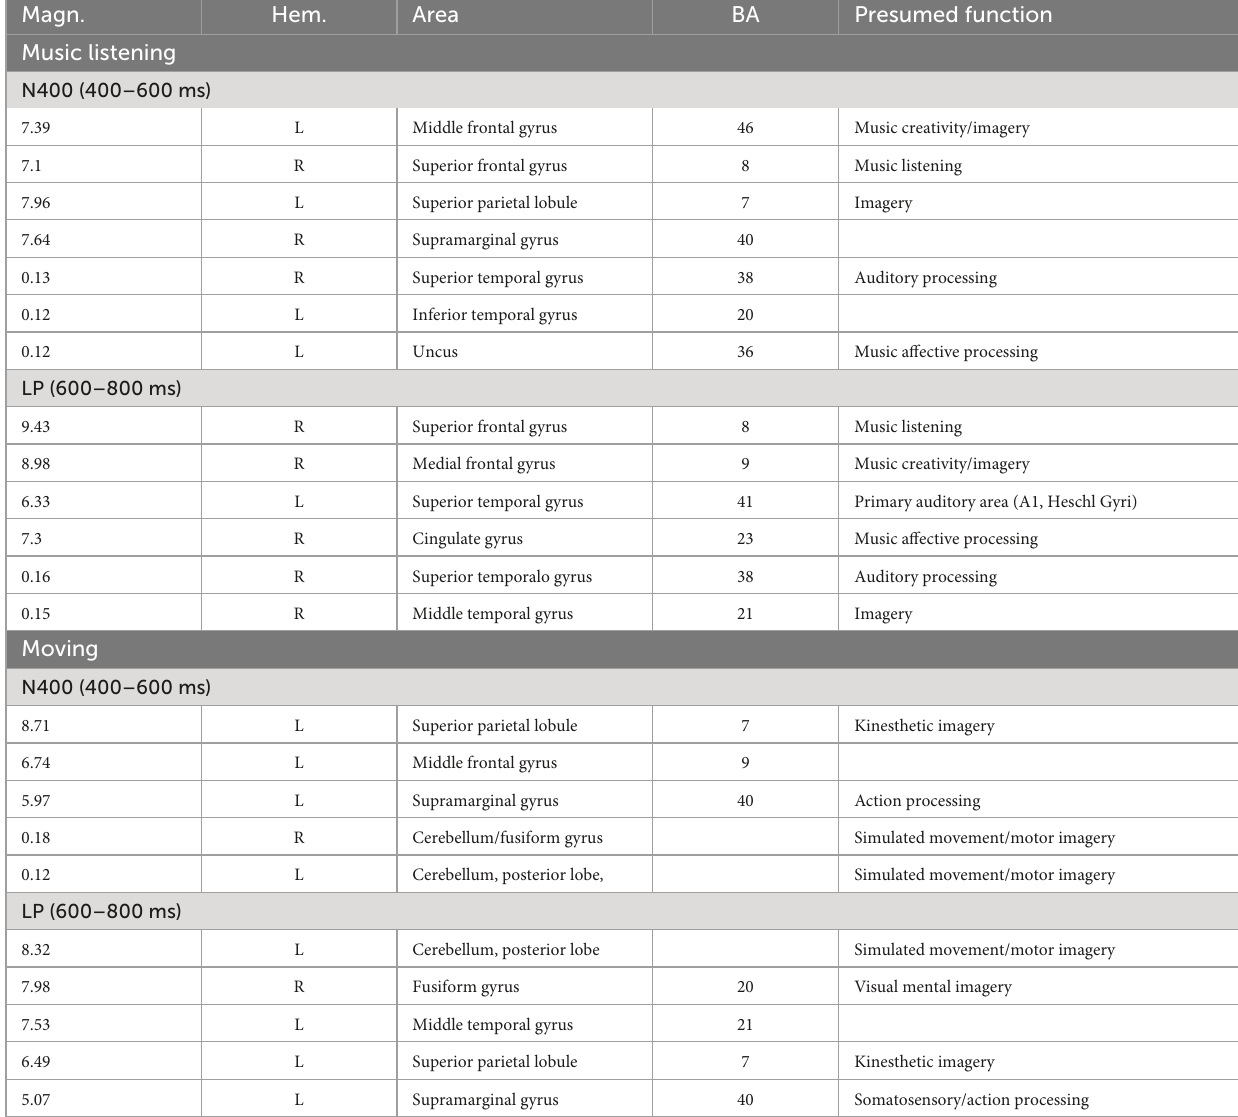
TABLE 3 List of active electromagnetic dipoles explaining the surface voltage of N400 and LP surface potentials according to swLORETA. Magn. Hem. Area BA Presumed function Music